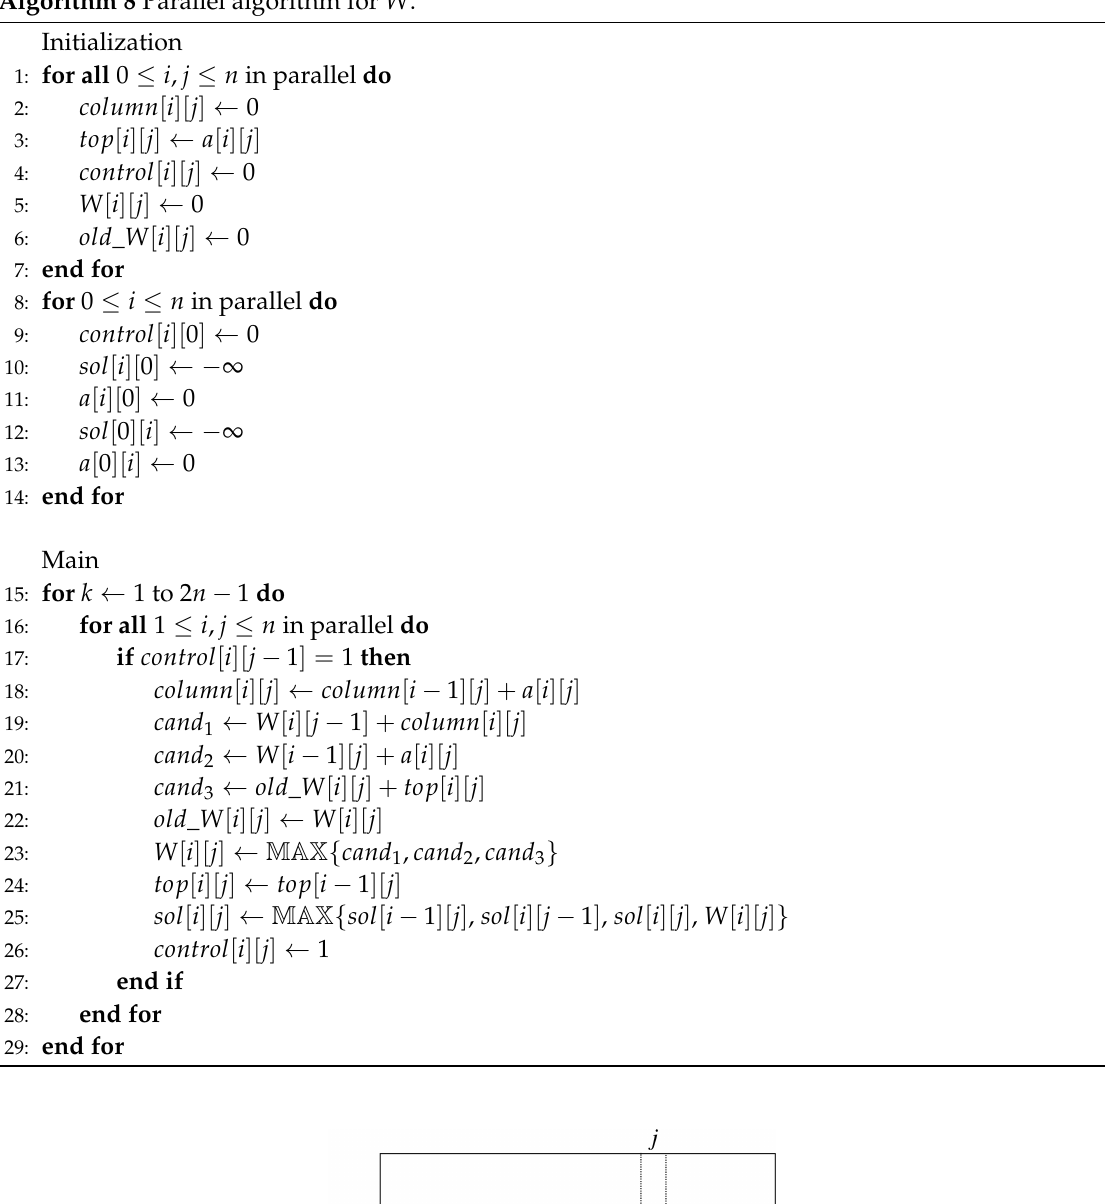
Algorithm 8 Parallel algorithm for W .